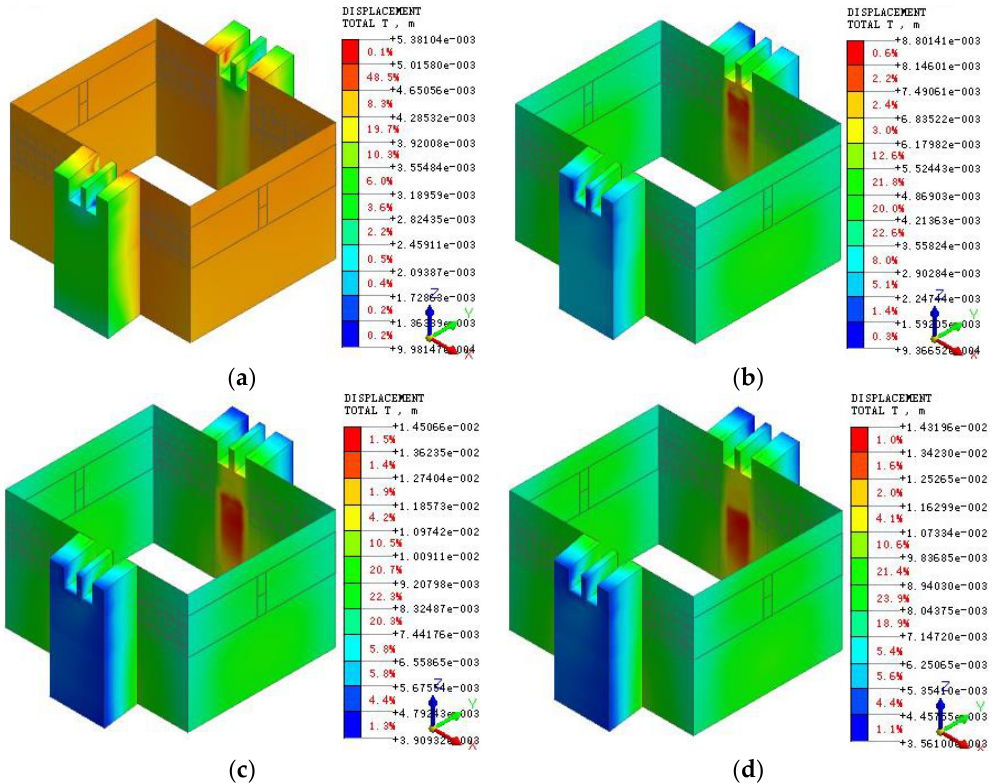
Figure 9. Displacement contours of diaphragm wall and MJS retaining wall at: ( a ) Excavation Step 3; ( b ) Excavation Step 5; ( c ) Excavation Step 6; ( d ) Excavation Step 8.